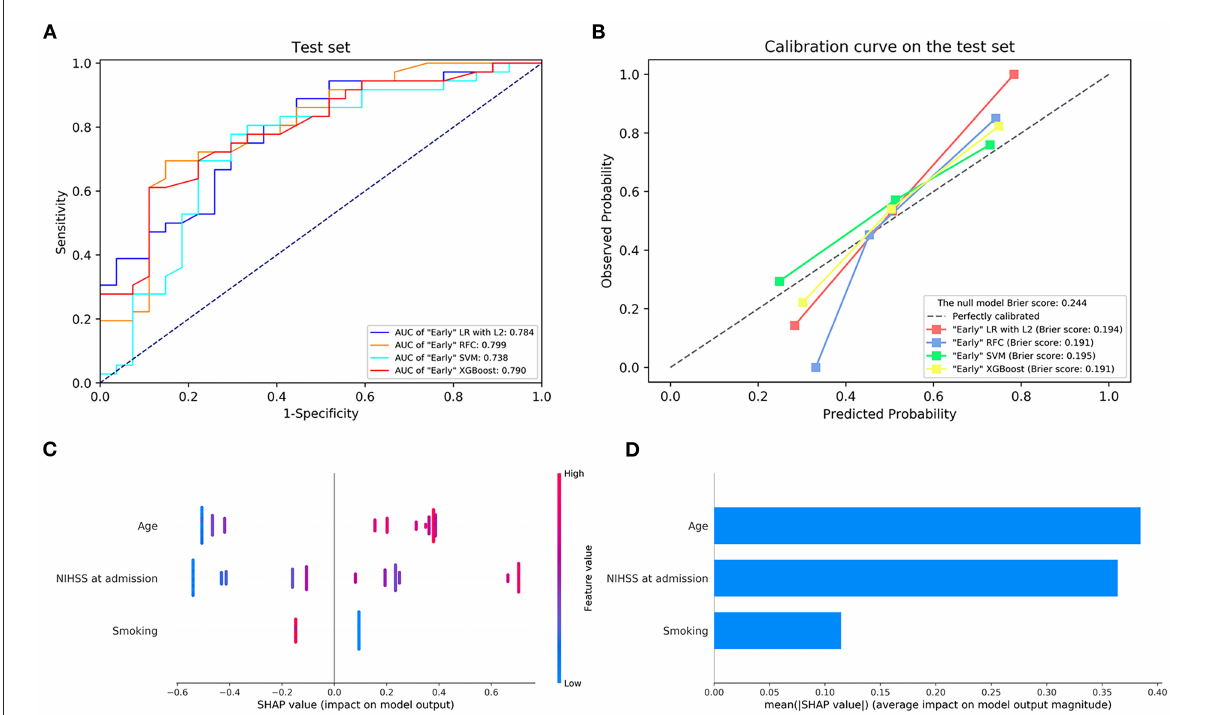
FIGURE1 (A) The receiver operating characteristic curve and (B) the calibration curve of the “Early” machine learning models on the testing set. (C,D) Feature importance ranking based on Shapley Additive exPlanations (SHAP) values in “Early” XGBoost. AUC, area under the curve; LR with L2, logistic regression with L2 regularization; SVM, support vector machine; RFC, random forest classifier; XGBoost, extreme gradient boost. NIHSS, National Institutes of Health Stroke Scale.